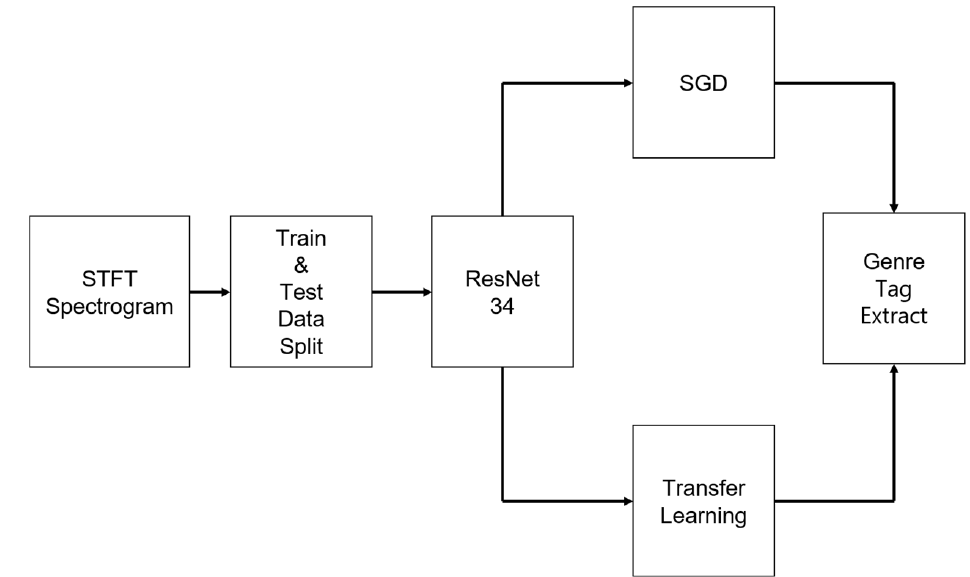
Figure 4. Genre analysis system.